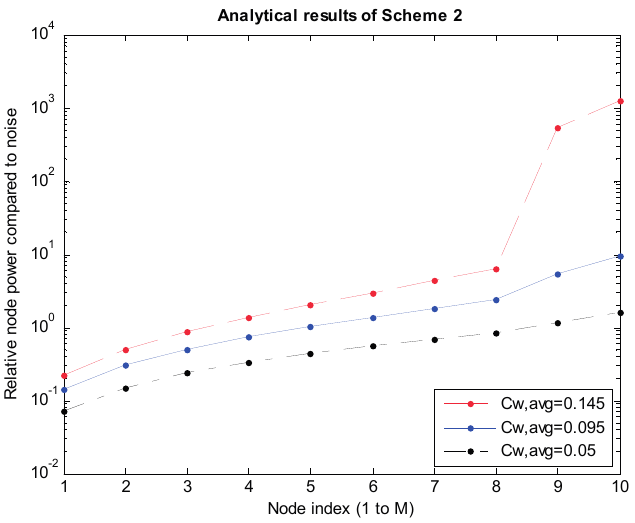
Figure 6. Power levels according to the node in Scheme